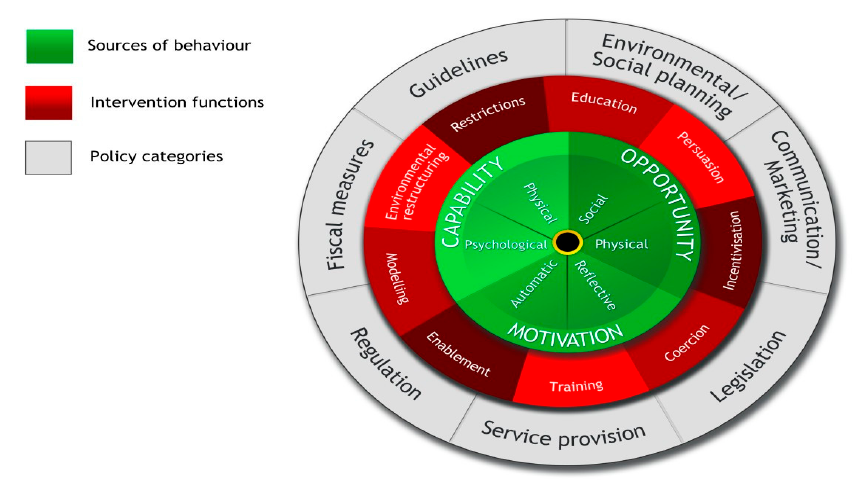
Figure A1. The behaviour change wheel [23].